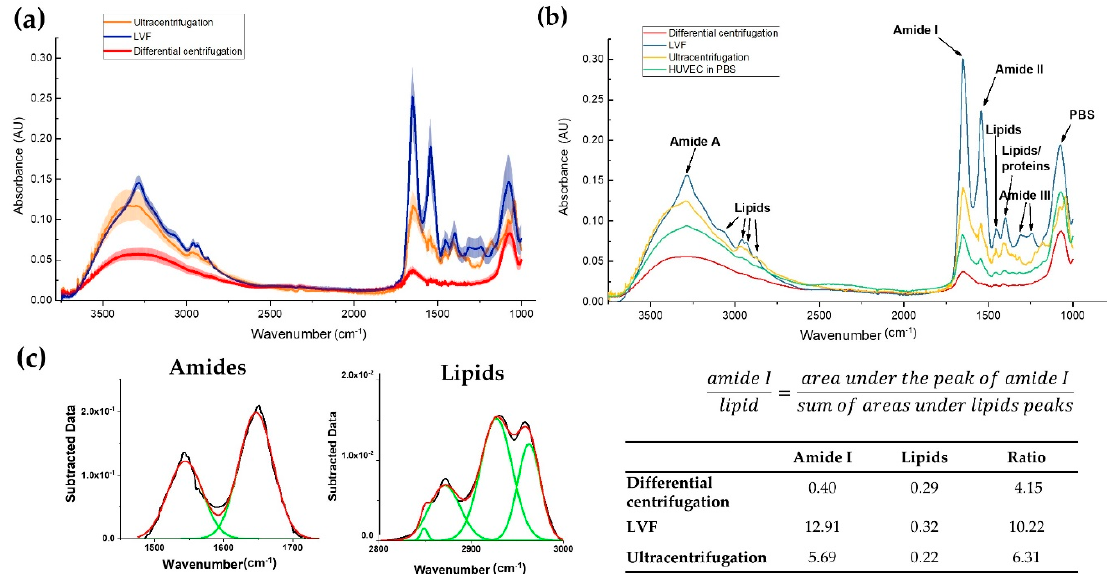
Figure 6. Results of the FTIR analysis. ( a ) Average infrared spectra for EVs isolated with the tested methods (line) with the SD of three independent measurements (upper and lower edges of the colored areas); ( b ) Comparison of the EVs spectra with the spectra of HUVEC cells with the assignment of the main peaks; ( c ) Example of the Gaussian function fitting for amide I / lipids ratio calculation with results (see the table). HUVEC: human umbilical endothelial vein cells.